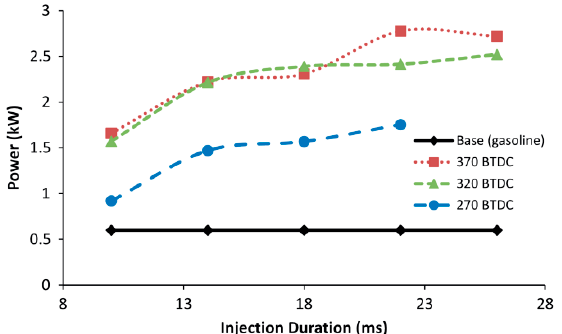
Figure 4. Effect of volume fraction of ammonia and air coefficient. ( a ) on CO 2 emissions; ( b ) on NOx emissions.